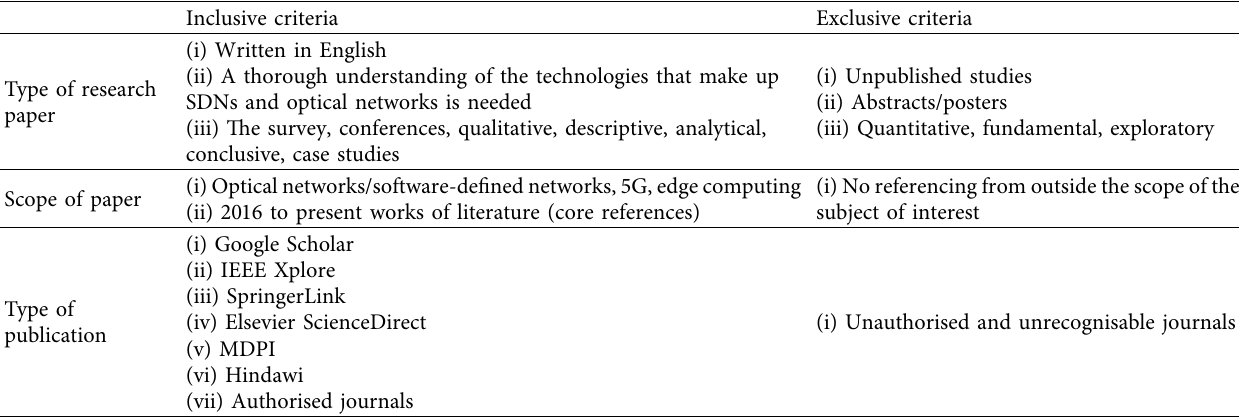
Table 2: Inclusive and exclusive selection methods.